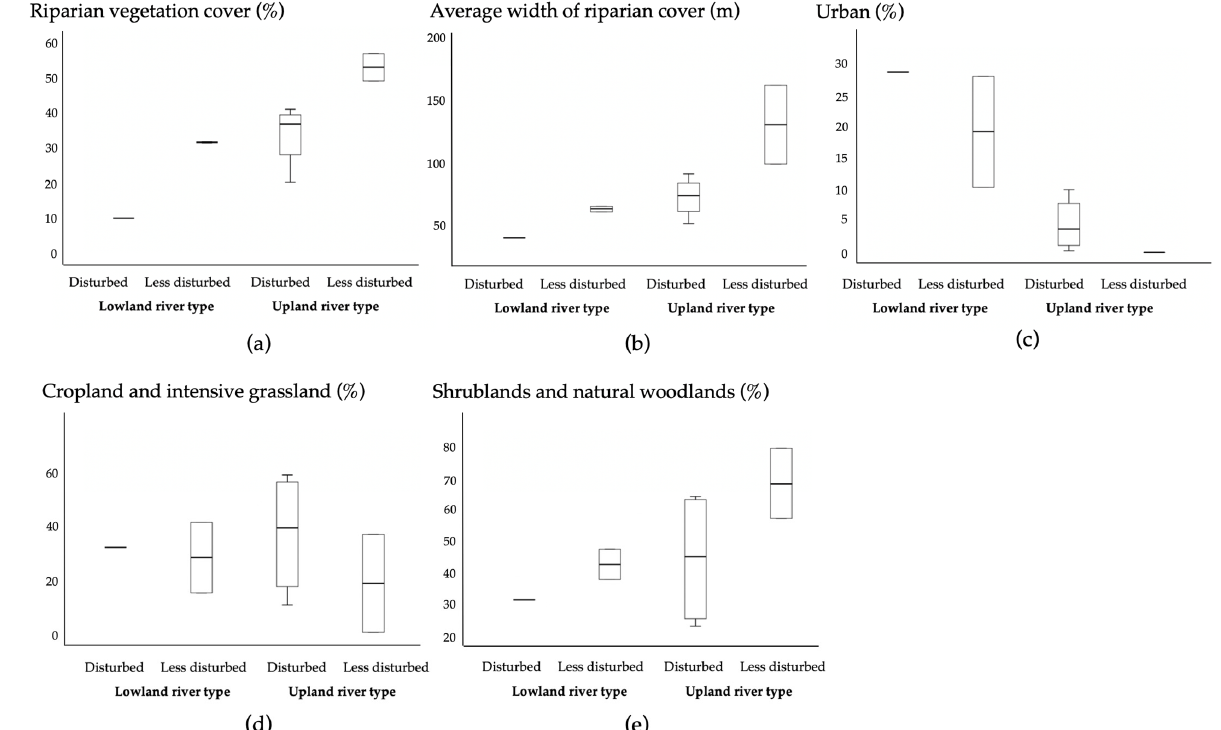
Figure 3. Box plots of: ( a ) Riparian vegetation cover; ( b ) Average width of riparian cover; ( c ) Urban LULC; ( d ) Cropland and intensive grassland LULC; ( e ) Shrublands and natural woodlands LULC, at disturbed and less disturbed sites in the upland and lowland river types. Boxes show interquartile ranges (25th and 75th percentiles), middle lines are medians, and whiskers are non-outlier ranges beyond the boxes.